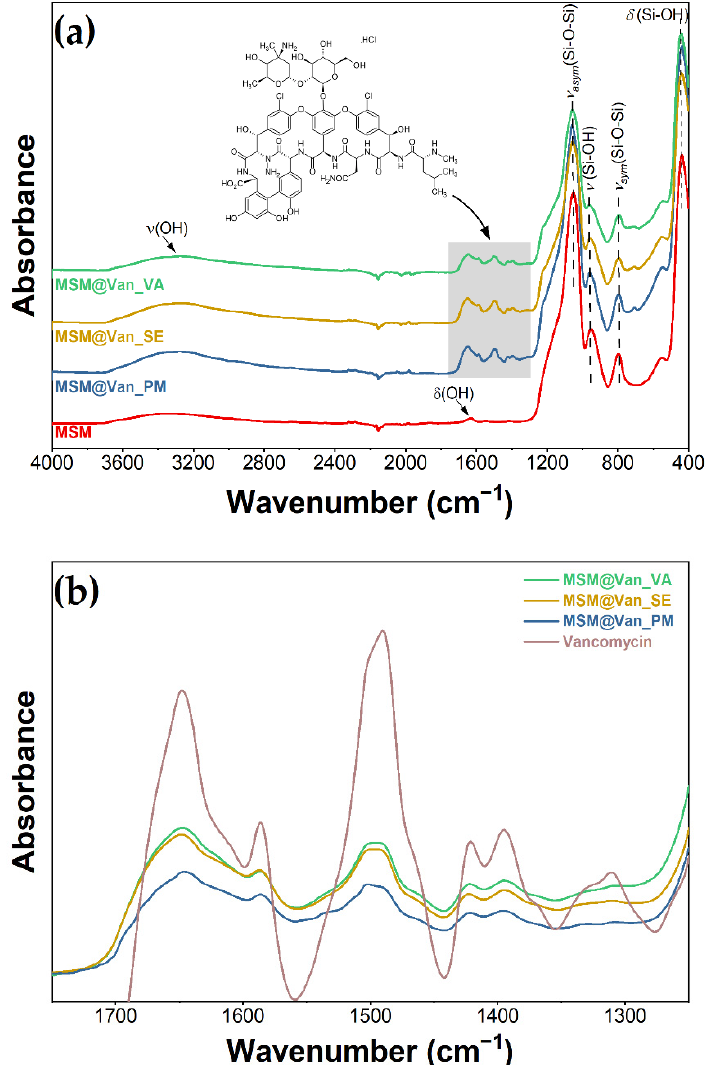
Figure 3. Infrared spectra ( a ) before and after loading with vancomycin; ( b ) overlapped spectra of loaded materials and vancomycin.